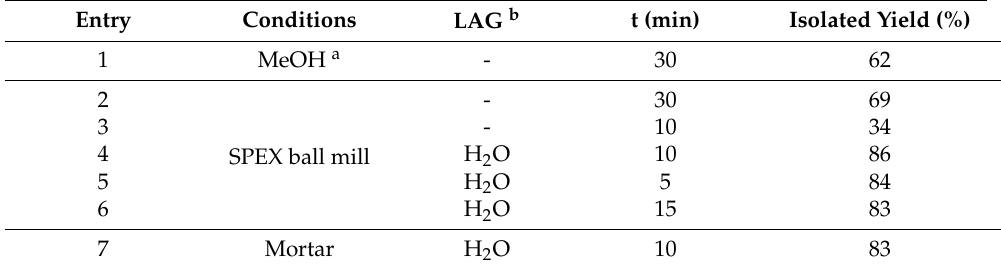
Table 1. Comparative conditions for the synthesis of N -dodecyl- D -galactonamide 1a